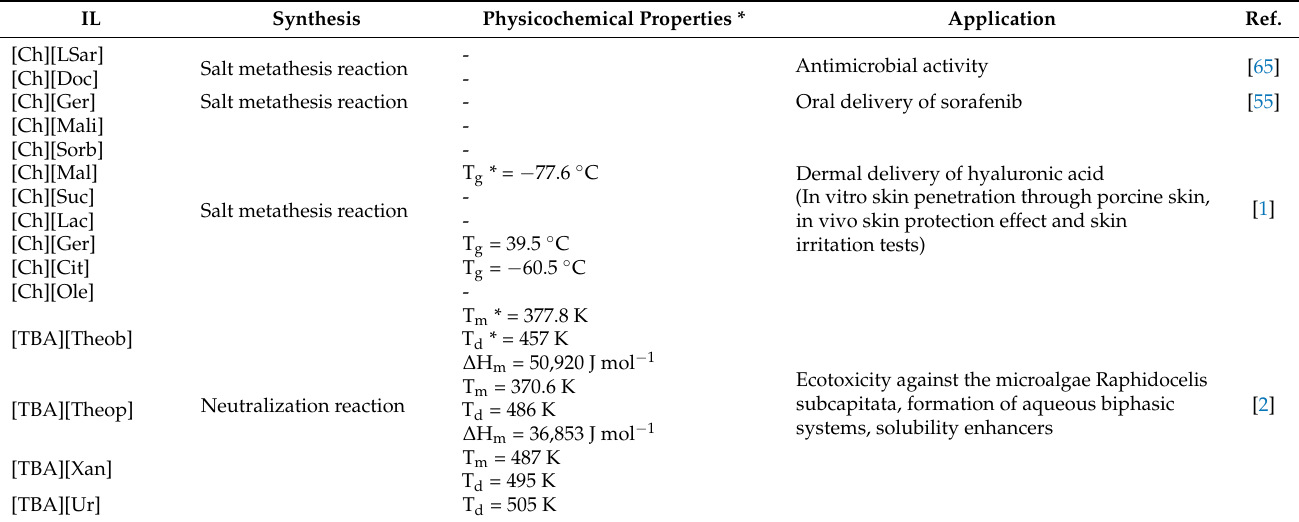
Table 3. Overview of recently investigated Bio-ILs in biomedical